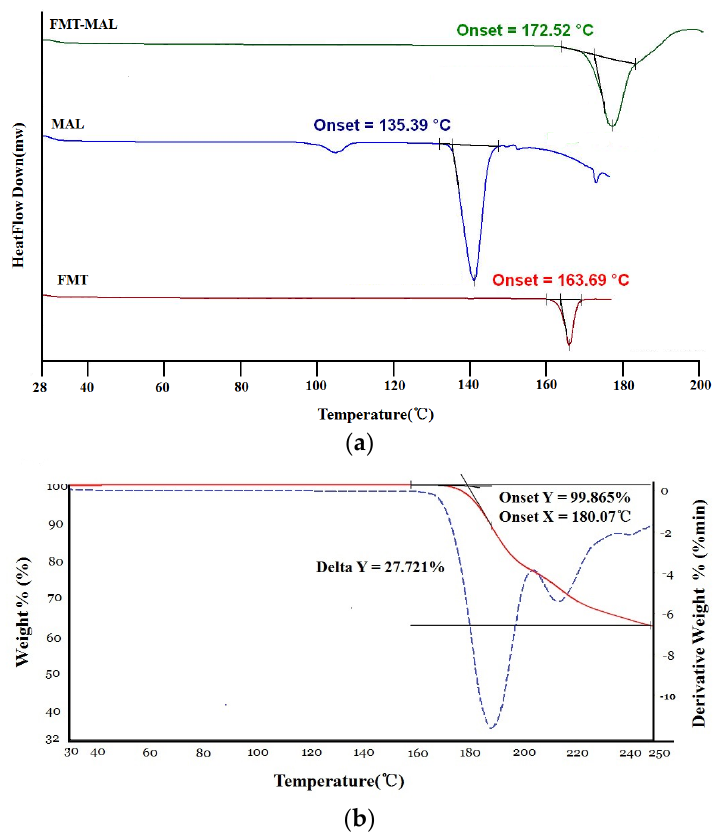
Figure 4. ( a ) DSC and ( b ) TGA thermograms of FMT-MAL.